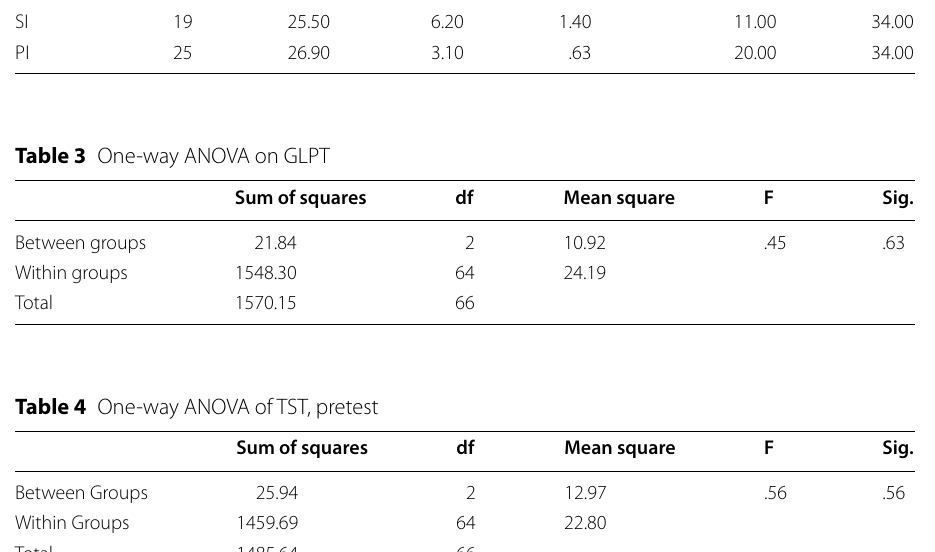
Table 2 Descriptive statistics of the groups on GLPT Groups N Mean SD Std. error Min Max EI 23 26.60 SI PI 34.00